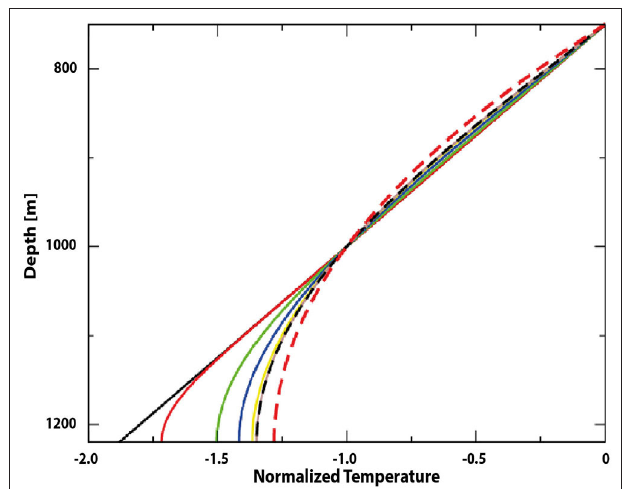
FIGURE 2 | Temperature profiles from the numerical model given by the unforced heat equation (1) (all values are divided by the temperature difference between 750 and 1,000 m depths) for the initial condition (black line), after 1 month (red), 6 months (green), 1 year (blue), 2 years (yellow), and 10 years (brown) of the integration time ( κ = 5 · 10 − 4 m 2 s − 1 ). The black dashed line is the analytic solution of the first mode, to which the dynamics converge. The red dashed line is the parabolic profile of the continuous